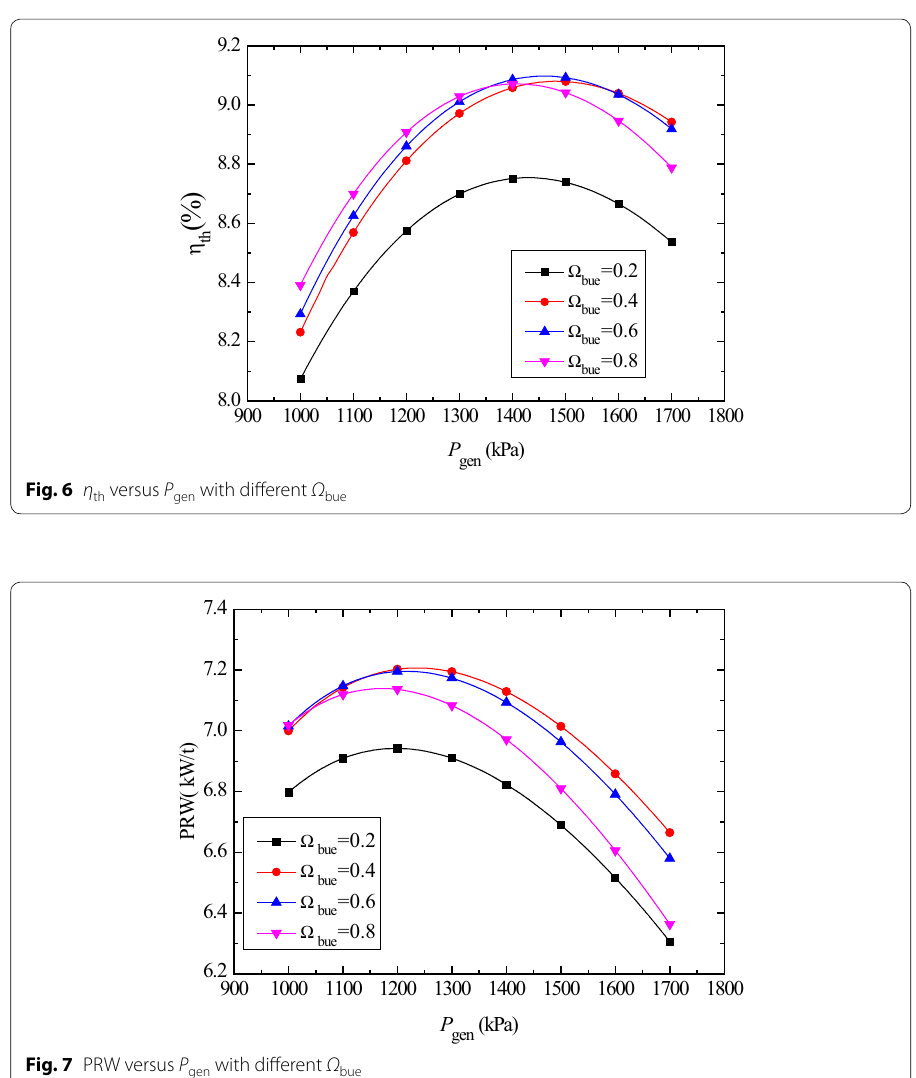
Fig. 7 PRW versus P gen with different Ω